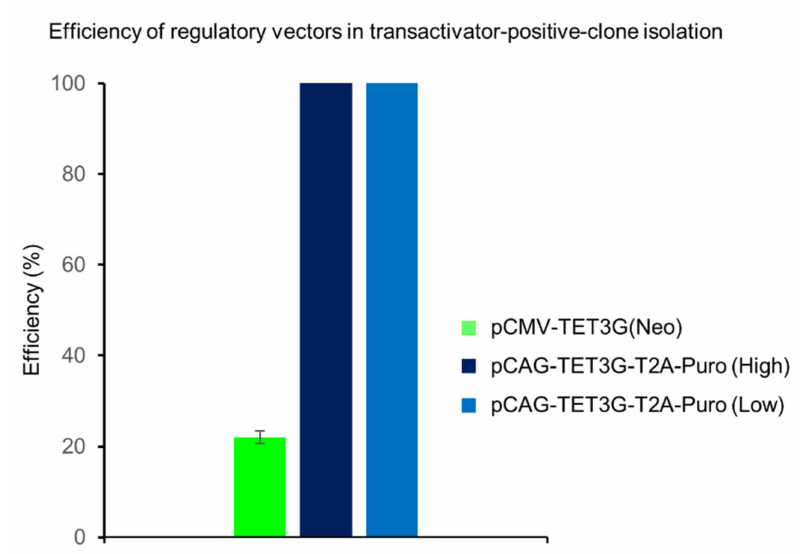
Figure 2. Efficiency of the newly designed system for inducible gene expression. The TetOn- 3G-T2A-Puro-based system provides four times higher efficiency in isolating clones that express the transactivator stably vs. the standard Tet-On 3G system (Takara). HEK293 (Human Embryo Kidney) cells were transfected with either pCMV-TET3G(Neo R ) or reengineered pCAG-TET3G- T2A-Puro, followed by treatment with selection antibiotics, geneticin (G418) and Puro, respectively. Efficiency was monitored for one concentration of G418 (1200 µ g/mL) and two concentrations of Puro: low (0.5 µ g/mL) and high (1.2 µ g/mL). For each system, more than 20 single cell clones resistant to the selection agents were isolated in two independent biological replicates and 11 from those that survived were cultured and transfected with a response plasmid coding GFP under a Dox inducible promoter. The Dox-induced expression of GFP was monitored under a fluorescence microscope. Efficiency is presented in “%” and describes how many clones, among all that survived the isolation, expressed the GFP transgene in response to the Dox treatment. The data is presented as mean ± standard deviation (SD) from two independent